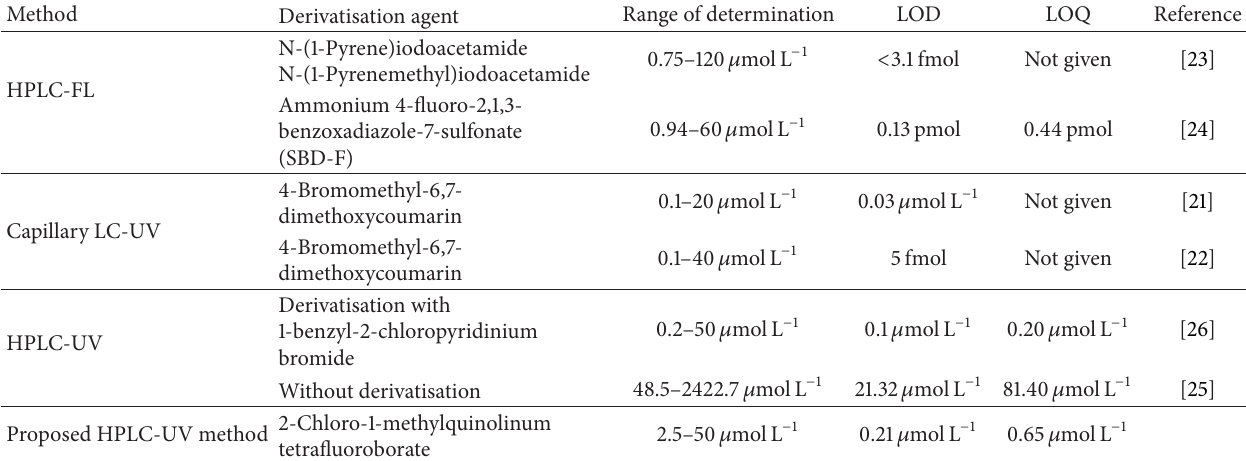
Table 4: Comparison of the proposed method with elaborated methods of analyzing